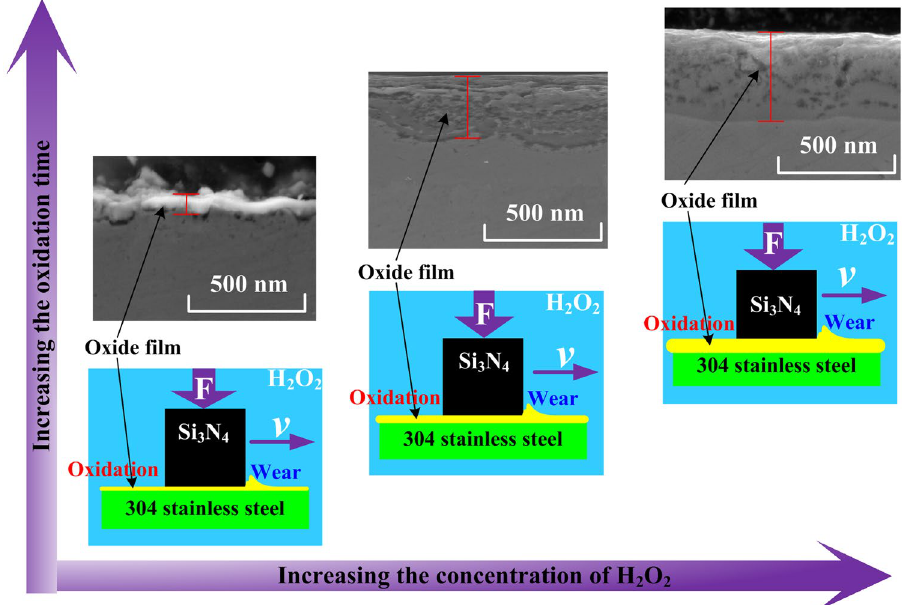
Figure 6. The coupling mechanism between the wear and oxidation